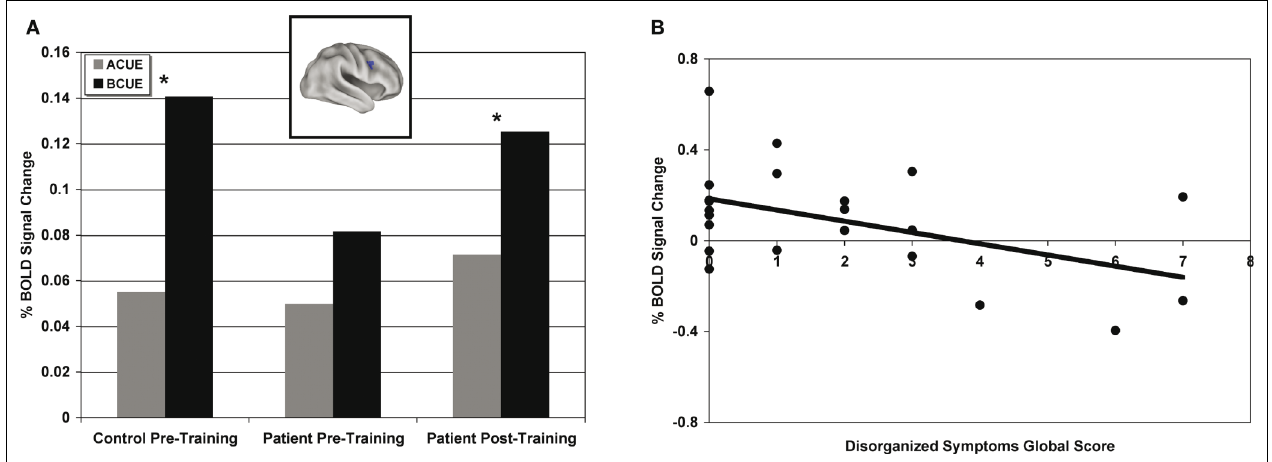
FIGURE 2 | (A) Right inferior frontal junction region ( x = + 45, y = + 10, z = + 30) showing signifi cantly greater B-cue relative to A-cue in healthy controls prior to training and signifi cantly greater B-cue relative to A-cue in patients post-training. (B) Pre-training B-cue activity averaged across